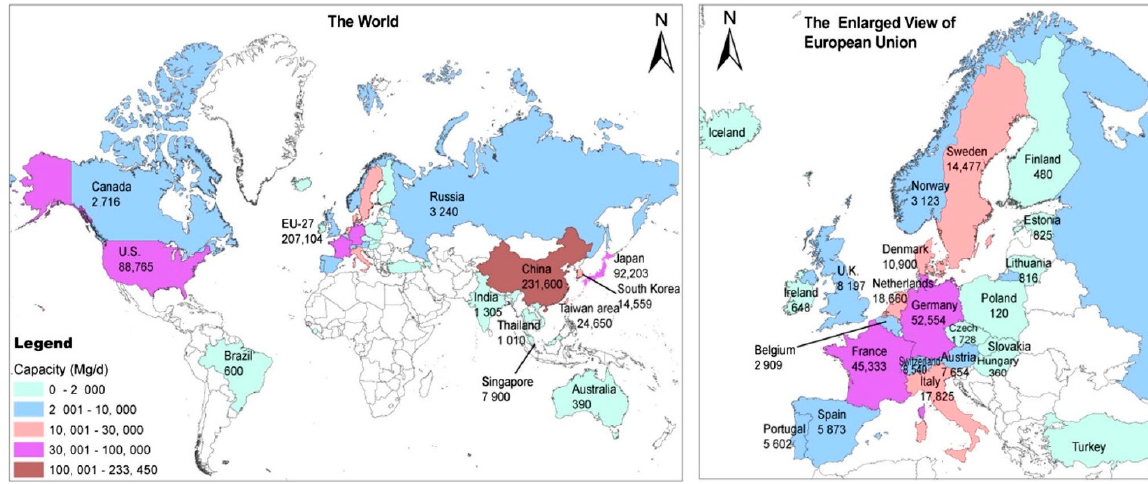
Figure 7. Global map of MSW incineration, reprinted with permission from Ref. [40].